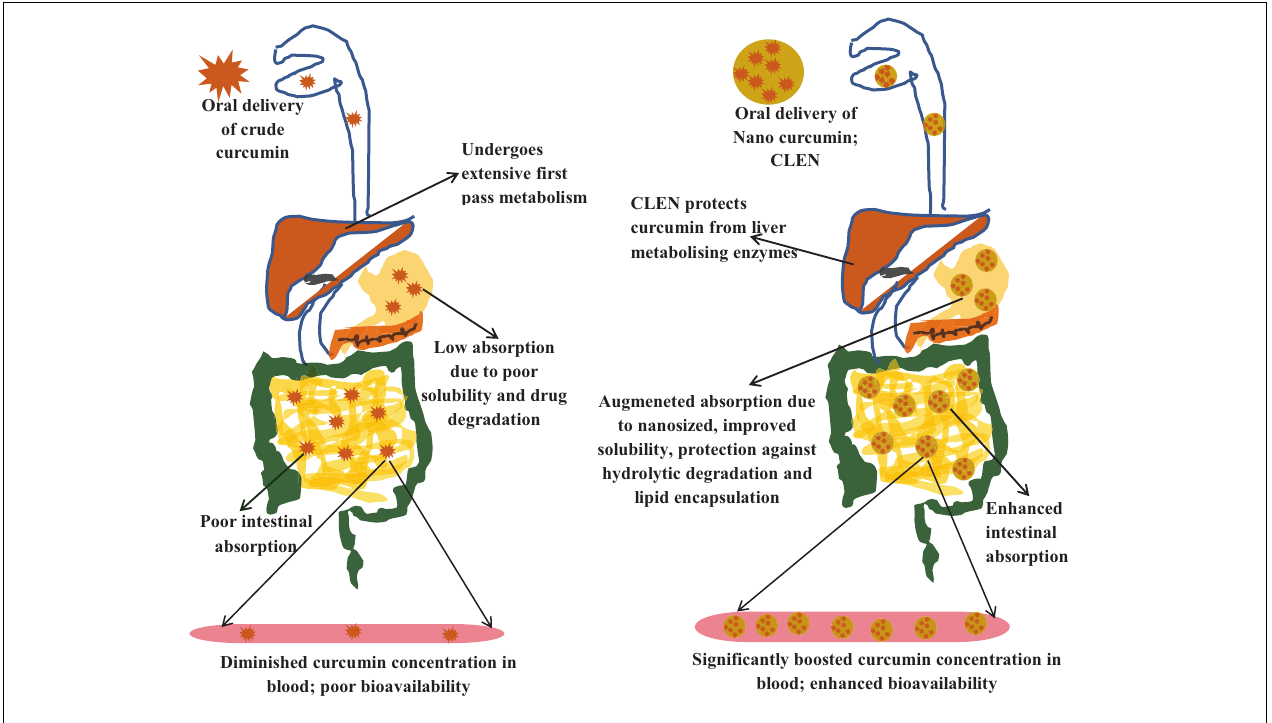
FIGURE 8 | Diagrammatic representation for benefits of encapsulation of curcumin as